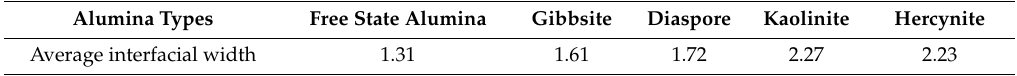
Table 10. The average interfacial width of di ff erent types of alumina